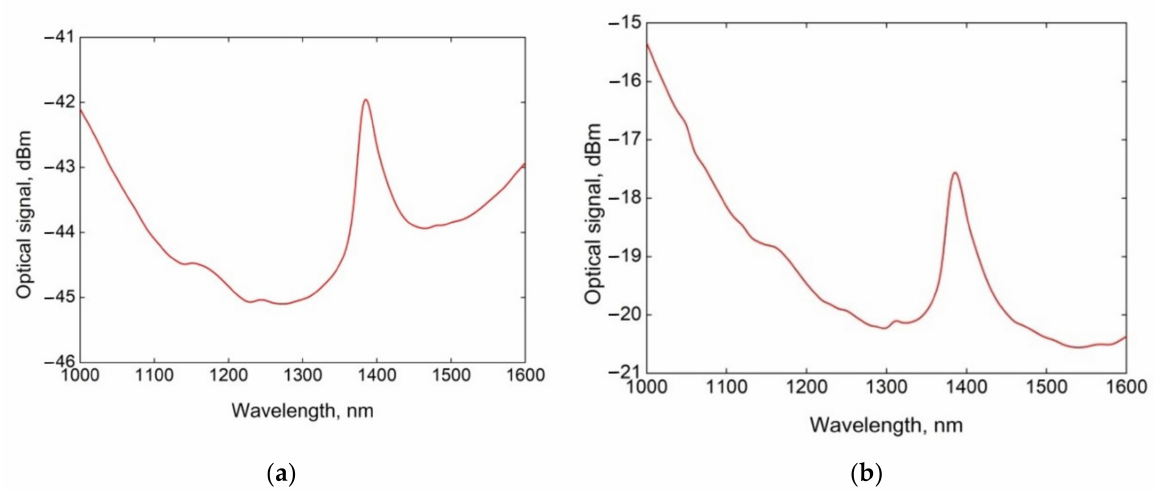
Figure 14. Six-core-MOFs with step-index core supporting elements transmission spectra: ( a ) MOF with a twisting of 470 rpm; ( b ) MOF with a twisting of 570